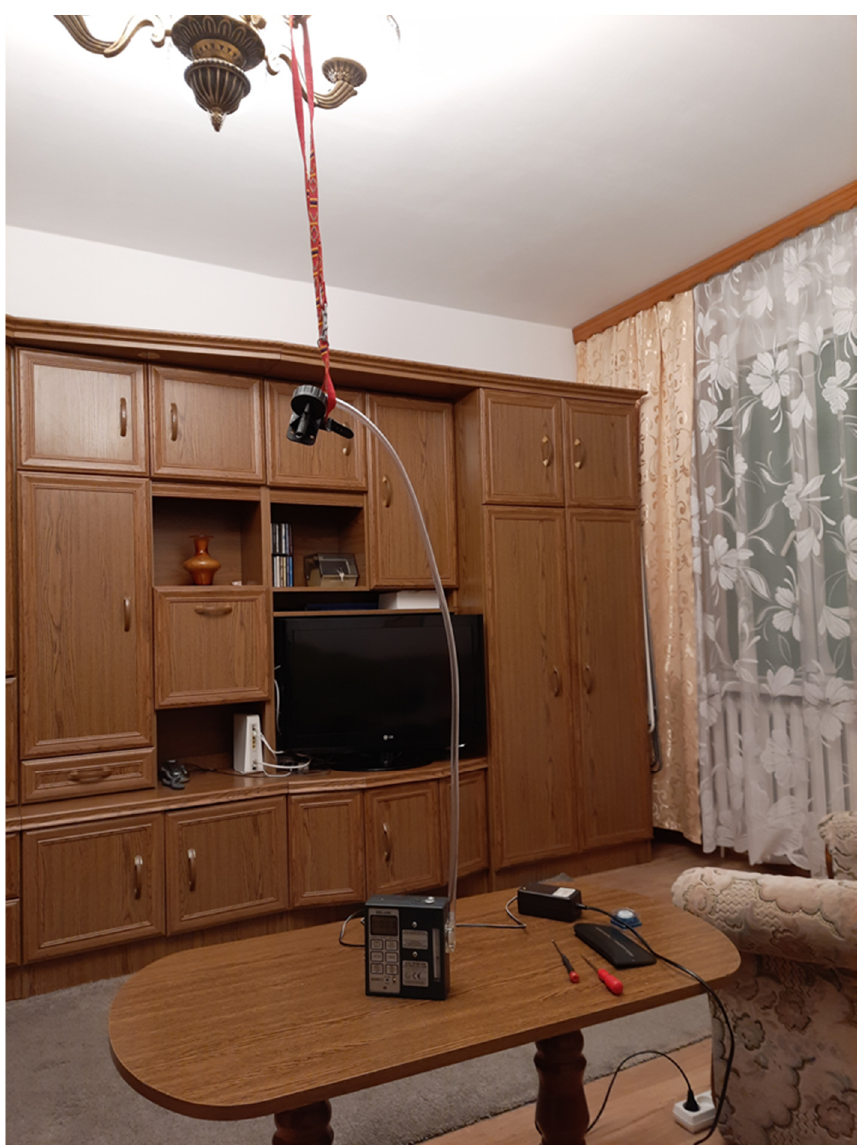
Figure 2. Photo of the SKC sampler with a head equipped with a cyclone with a cut-off diameter of 4 µm while measuring the concentration of airborne particles in one of the reference apartments in Katowice (no smokers).